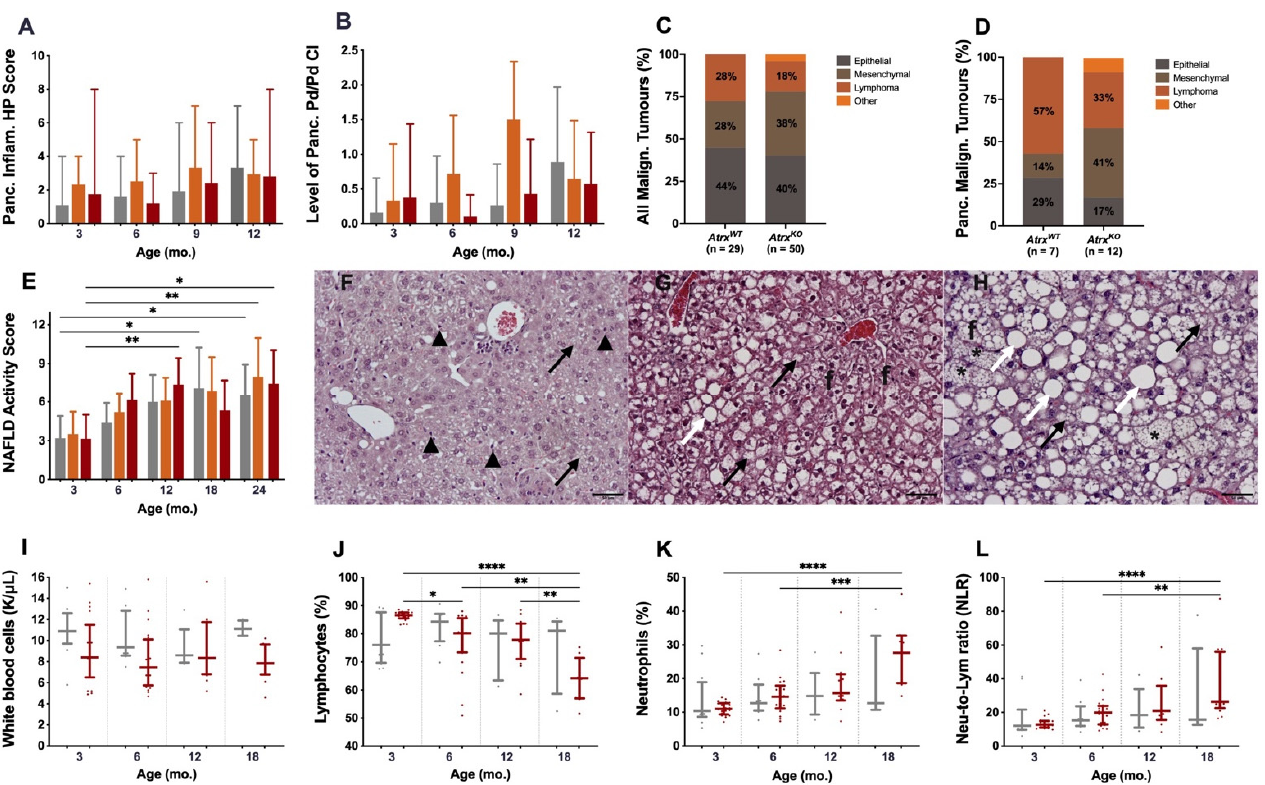
Figure 2. Inflammatory and tumoural lesions in pancreas, hepatic steatosis, and systemic inflammation in whole blood. Pancreatic inflammation is higher in Atrx KO mice, especially Atrx HET females ( A ), mostly due to increased periductal/perivascular (Pd/Pv) chronic inflammation (CI) ( B ) up to 12 mo.; there are no differences among genotypes. Tumour incidence analysis determined reveal diverse malignant tumoural phenotypes, either considering all tumour sites ( C ) or pancreas alone ( D ), where there is a slight predominance of mesenchymal phenotype in Atrx KO mice. Atrx KO mice, especially Atrx HET females, have increased NAS ( E ), in accordance with weight analysis (See Figure 4). Representative images of mild, moderate, and marked lesions of non-alcoholic fatty liver disease (NAFLD) activity score (NAS) ( F – H ), respectively, where black arrows represent microvesicular steatosis, white arrows represent macrovesicular steatosis, black arrowheads represent discrete lobular inflammation, circles represent microgranuloma, asterisks represent hypertrophy, and f represents fibrosis; the three images are at 200× magnification. Hemograms made clearly to conclude inflammation is rather a local phenomenon in pancreas, as all evaluated parameters are not consistently increased in Atrx KO mice; even so, although white blood cell count is not consistently higher in Atrx KO mice ( I ), lymphocytes percentage reaches its highest value by 3 mo. and then decreases over time ( J ), accompanied by the inverse pattern in neutrophils population ( K ); from 6 mo. on, the neutrophil-to-lymphocyte ratio (NLR) is slightly higher in Atrx KO mice than in Atrx WT controls ( L ). Results are shown as mean +/ − range values ( A ), mean +/ − SD ( B,E ), and median +/ − IQR ( I – L ). * p < 0.05, ** p < 0.01, *** p < 0.001, **** p < 0.0001.